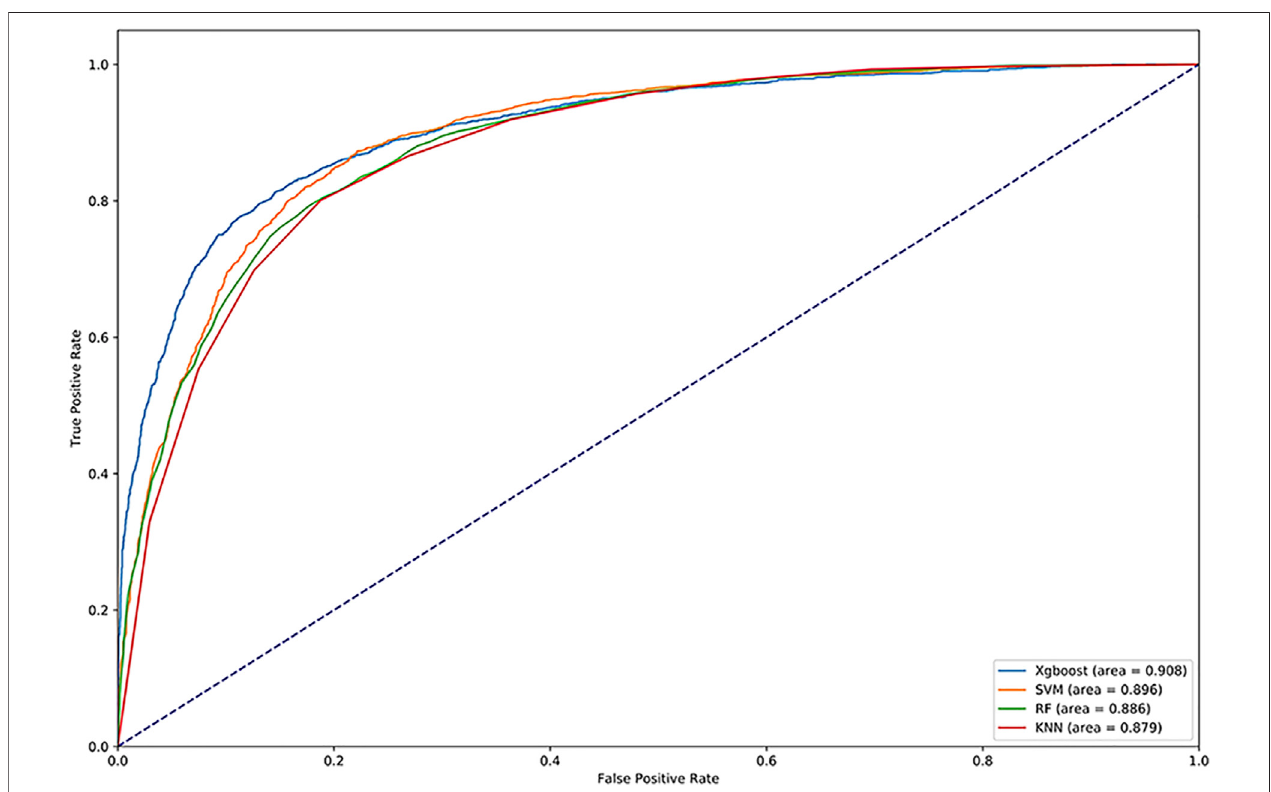
FIGURE 4 | ROC curve of vesicle transporters identi fi ed by different methods.